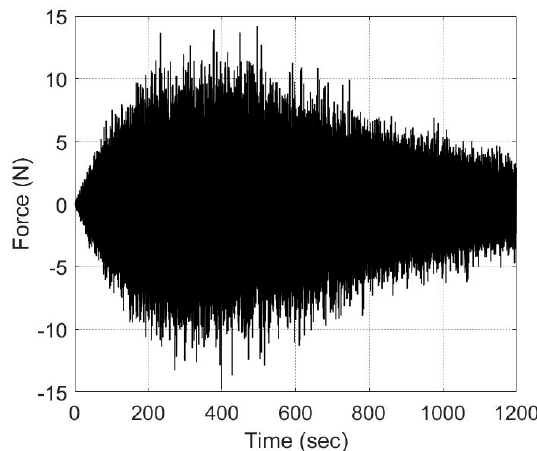
Figure 4. Sample function of nonstationary excitation.